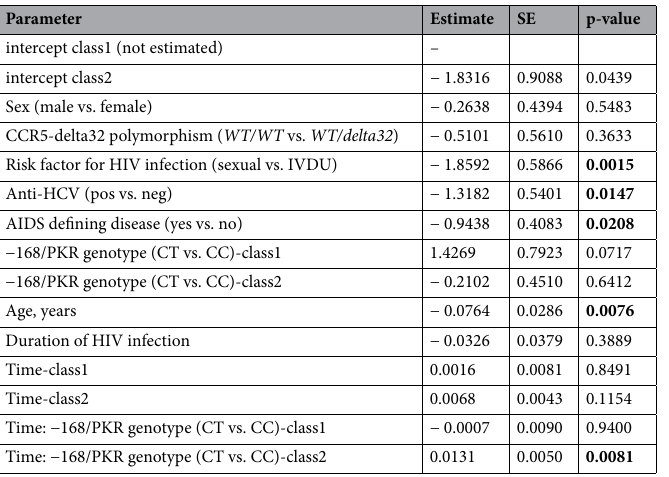
Table 2. Estimated latent class mixed model for CD4 (square root transformed) with two latent classes. The “time: −168/PKR genotype” indicates the parameter for the interaction term, i.e., it describes the progression of CD4 separately for each allelic variant and for each latent class (class1 or class2). WT/WT wild type, anti-HCV hepatitis C virus antibodies, AIDS acquired immune deficiency syndrome, PKR protein kinase R. Significant coefficients are in bold.